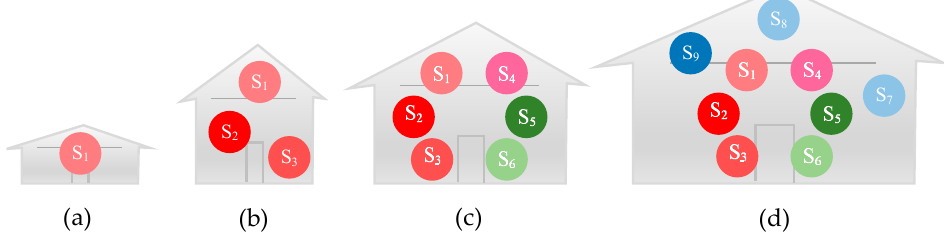
Figure 2. Embedded-system layout applications. ( a ) One, ( b ) three, ( c ) six, and ( d ) nine embedded systems.